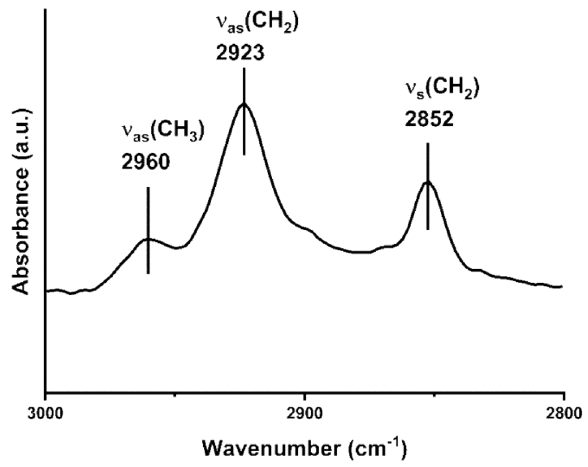
Figure 2. C–H stretching region of ATR-FTIR spectra of OTS self-assembled monolayer formed on the metallurgical polished aluminum